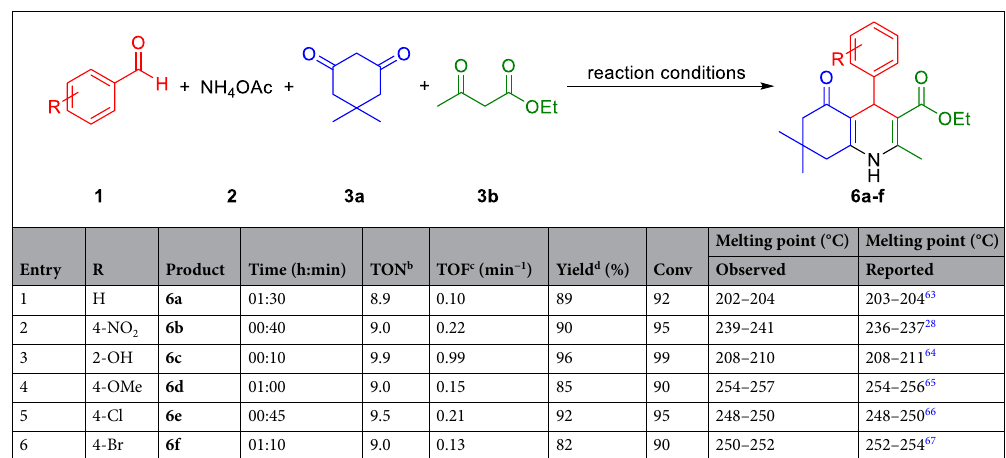
Table 2. One-pot synthesis of PHQ derivatives a . a Reaction conditions: aldehydes (1.0 mmol), dimedone (1.0 mmol), ethyl acetoacetate (1.0 mmol), ammonium acetate (1.0 mmol), n-Fe 3 O 4 @SiO 2 -TA-SO 3 H IL in EtOH (5.0 mL) under reflux. b TON = Yield (%)/Catalyst amount (mol%). c TOF = TON/time (min). d Isolated